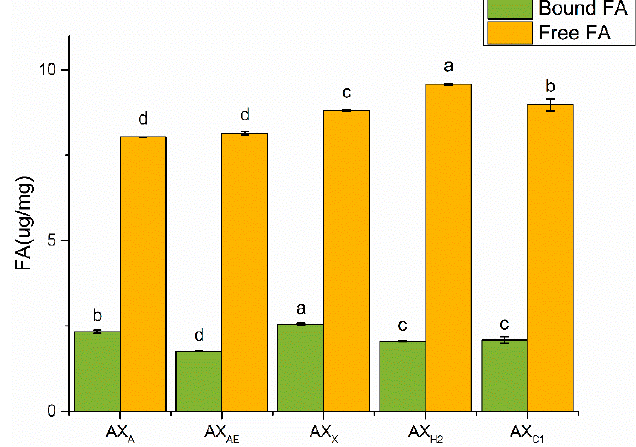
Figure 3. The content of FA in AXH. AX AE , triticale bran arabinoxylan was treated with α -L- arabinofuranosidase; AX C1 , triticale bran arabinoxylan was treated with 0.1 M citric acid; AX H2 , triticale bran arabinoxylan was treated with 0.15 M HCL; AX X , triticale bran arabinoxylan was treated with endo-1,4- β -xylanase. Values represented in this figure consist of mean ± standard deviation ( n = 3). Values with different superscript letter are significantly different ( p < 0.05).